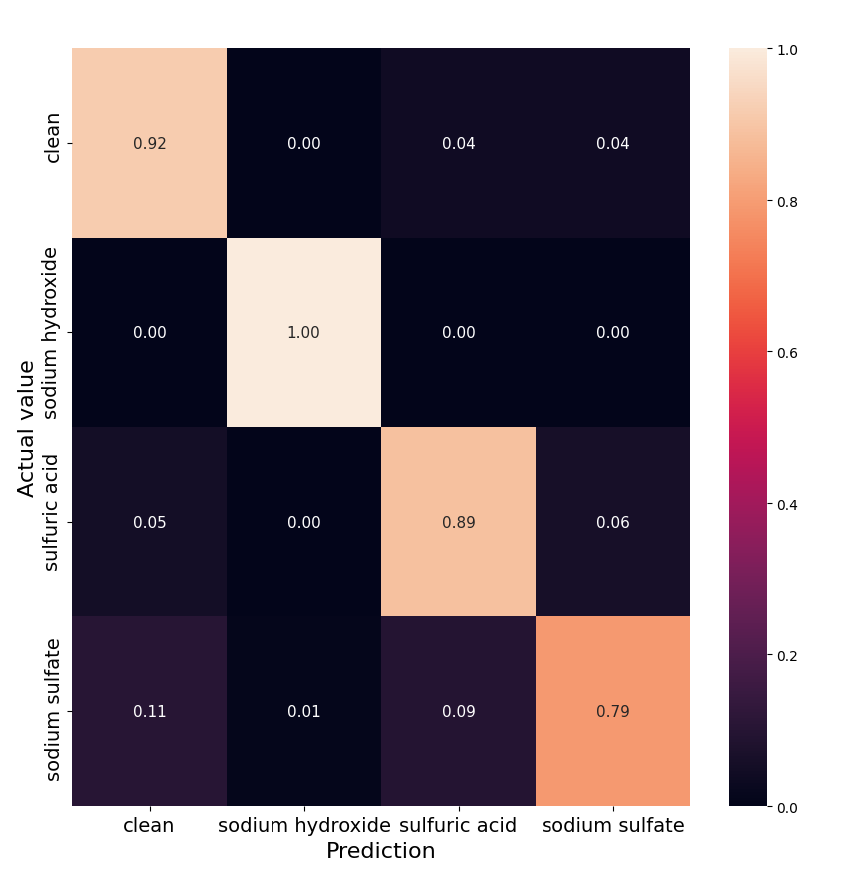
Figure 11. Confusion matrix for the pollutant classification based on the pH and electrical conductiv- ity measurements. Table 6. Prediction accuracy—pollutant source location